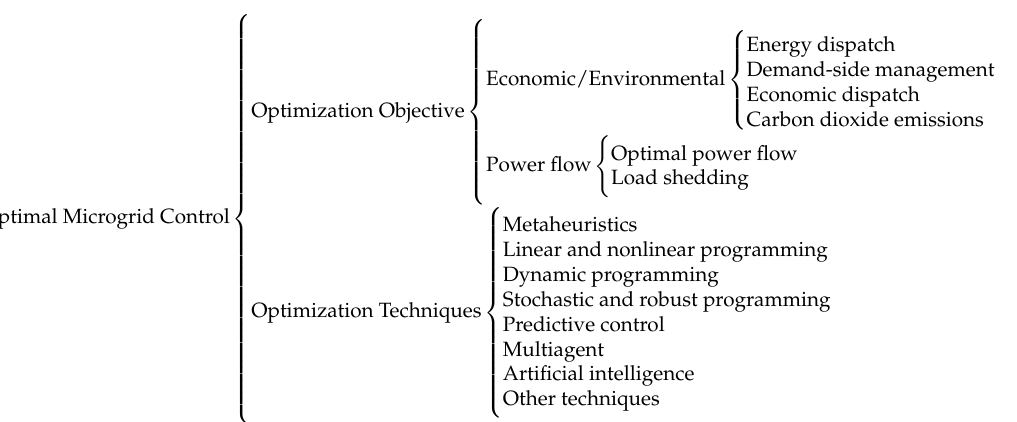
Figure 2. Classification of optimal control strategies for MGs’